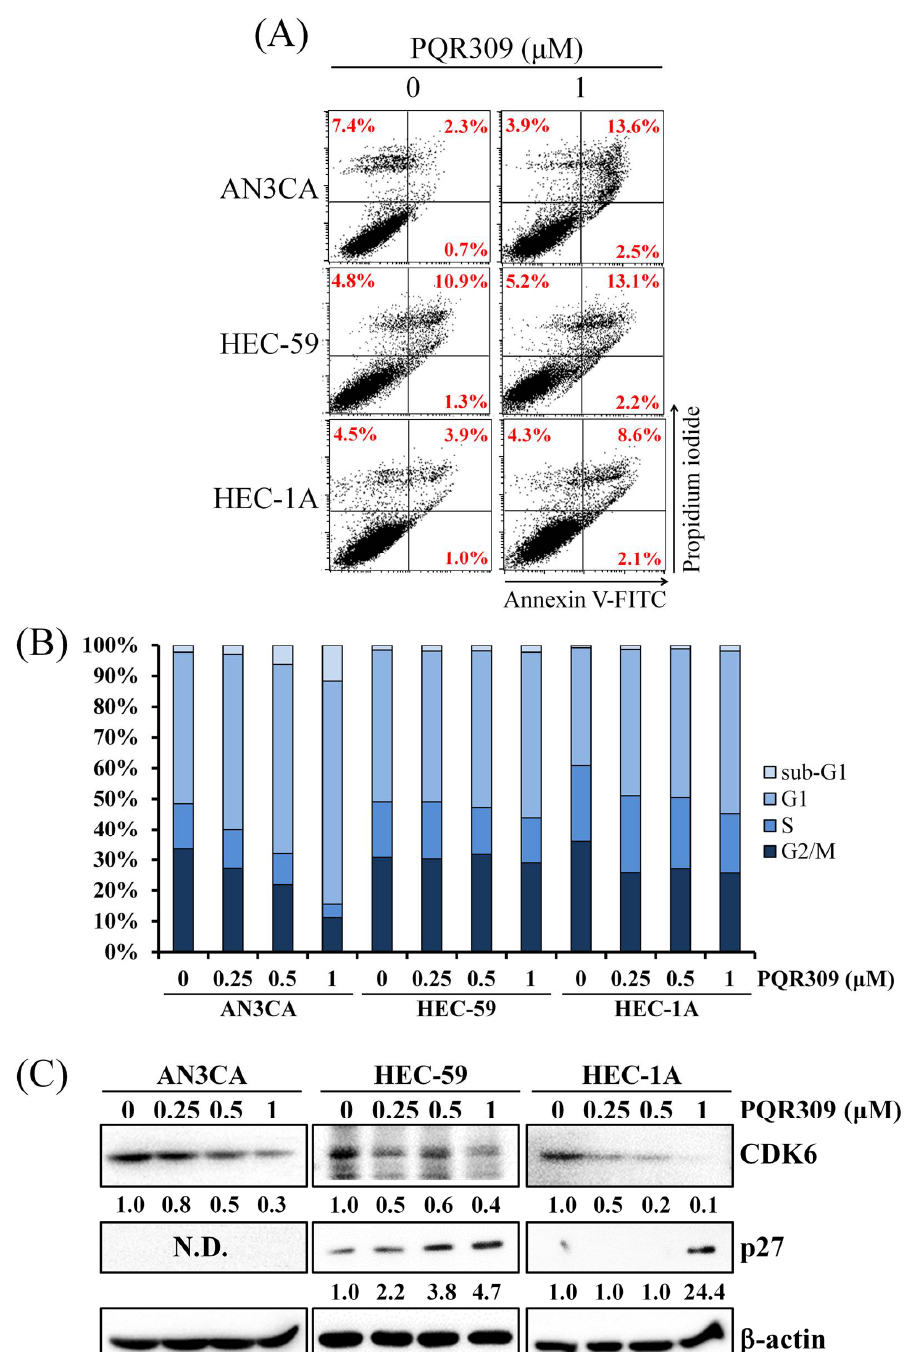
Figure 4. Effect of PQR309 on cell death and cell cycle arrest in endometrial cancer cells. ( A ) After treatment with PQR309 (0 and 1 µ M) for 48 h, indicated endometrial cancer cells were stained with annexin V-FITC/propidium iodine and analyzed by flow cytometry. ( B ) AN3CA, HEC-59, and HEC-1A cells were treated with PQR309 (0, 0.25, 0.5, and 1 µ M) for 48 h. After PI staining, cells were analyzed by flow cytometry. ( C ) After treating with PQR309 in AN3CA, HEC-59, and HEC-1A cells for 48 h, protein expressions of CDK6 and p27 were determined by Western blot. ImageJ software was used to quantify the band intensities of CDK6 and p27. Data shown are the relative expression standardized by the β -actin protein level. The ratio of cells without treatment was set at 1. N.D., not